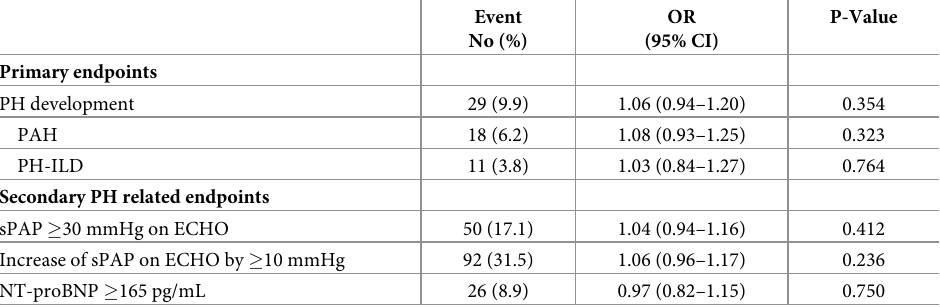
Table 5. Frequency and univariable logistic regression analyses of CX 3 CL1 and new events of primary and second- ary PH endpoints including during the observation period in the Oslo University Hospital SSc